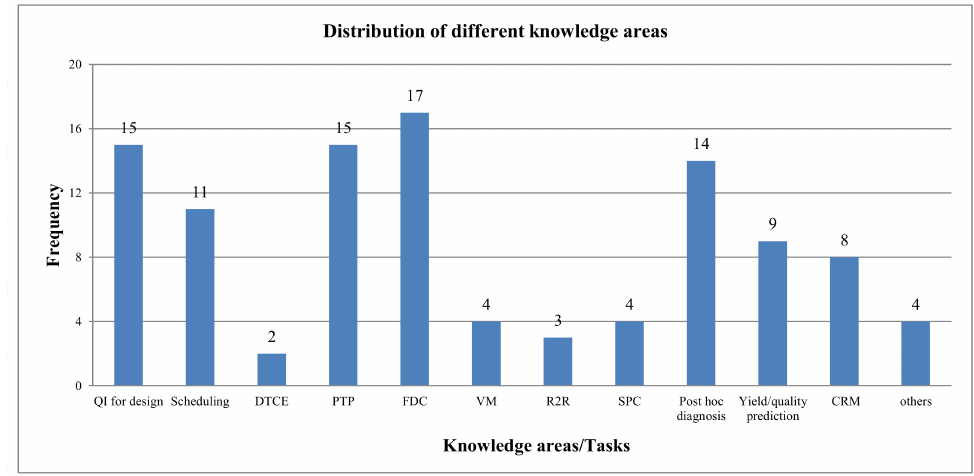
Figure 5. Distribution of different knowledge